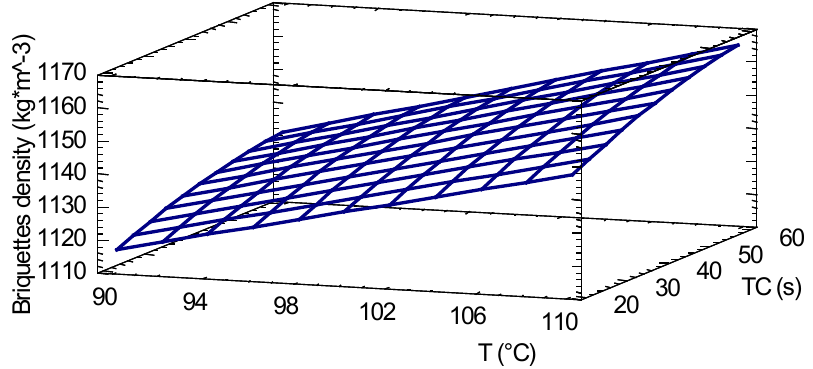
Figure 3. Estimated response surface for briquettes density as a function of process temperature and compaction time for a rice husk ratio of P = 50%.